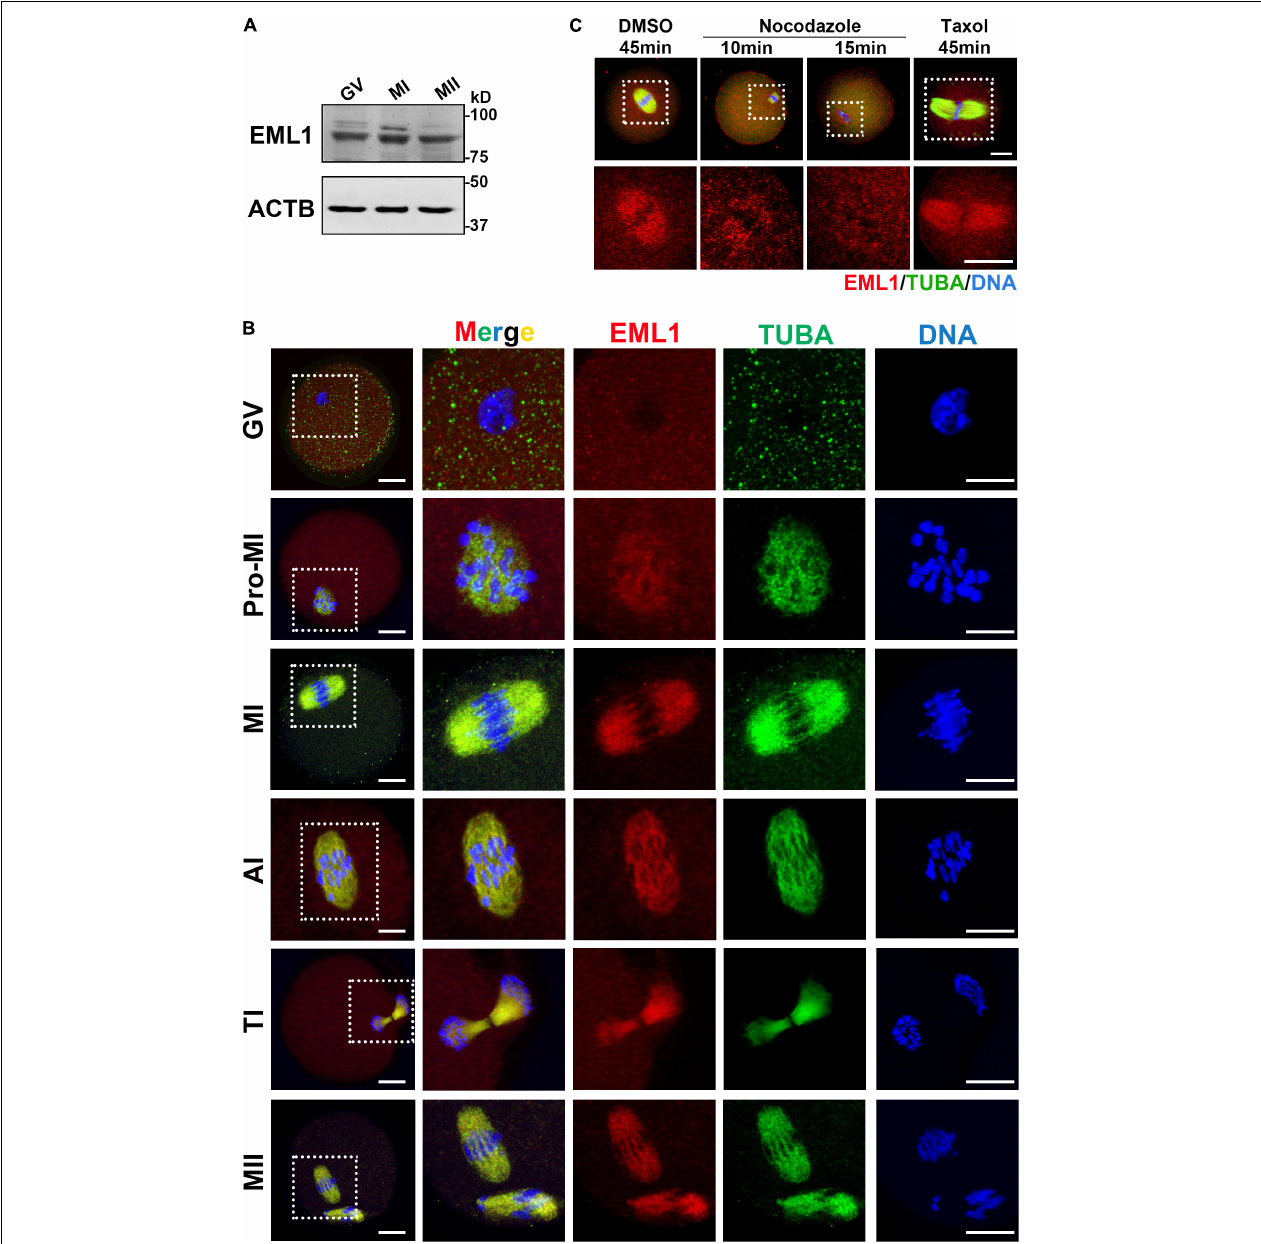
FIGURE 2 | Stable expression and specific localization of EML1 in mouse oocyte during meiotic progression. (A) Western Blot (WB) analysis of the expression of EML1 and ACTB (internal control) protein in oocytes at different stages of maturation. Lysate of 200 oocytes that were collected at 0, 8, and 14 h of IVM corresponding to GV-, MI-, and MII- stage, respectively, was load in each lane. (B) Confocal micrographs showing the dynamic co-localization of EML1 protein with meiotic spindles in oocytes at various stages (i.e., GV, Pro-MI, MI, AI, TI, and MII) of maturation. EML1 and α -tubulin were stained in red and green, respectively, while chromosomes were stained in blue. The far left panel shows the whole-oocyte view of the staining. The magnified view of the boxed area within the oocyte at each stage is listed on the right side. Scale Bar = 20 µ m. (C) Confocal micrographs demonstrating the changes of localization of EML1 and tubulin in MI- stage oocytes treated with microtubule-interfering drugs. MI- oocytes were treated with 20 µ g/ml nocodazole for 10 and 15 min, respectively, or with 10 µ M Taxol for 45 min, and then processed for IF analysis of EML1 and α -tubulin localization. EML1, α -tubulin, and chromosomes are shown in red, green, and blue, respectively. The first row indicates the whole-oocyte view of the staining. The magnified view of the boxed area within the oocyte is shown in the second row. Scale Bar = 20 µ m.